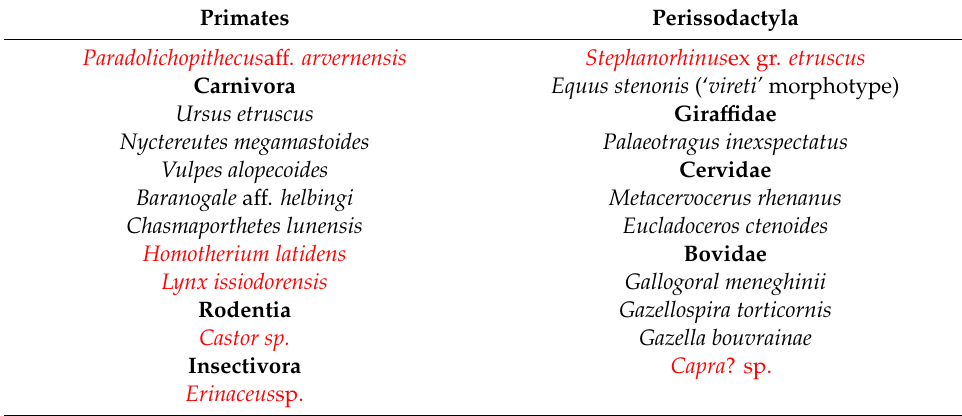
Table 1. Faunal association of Dafnero, Greece, combining evidence from DFN, DFN2 and DFN3 sites. Data from [24–30,48], and pers.